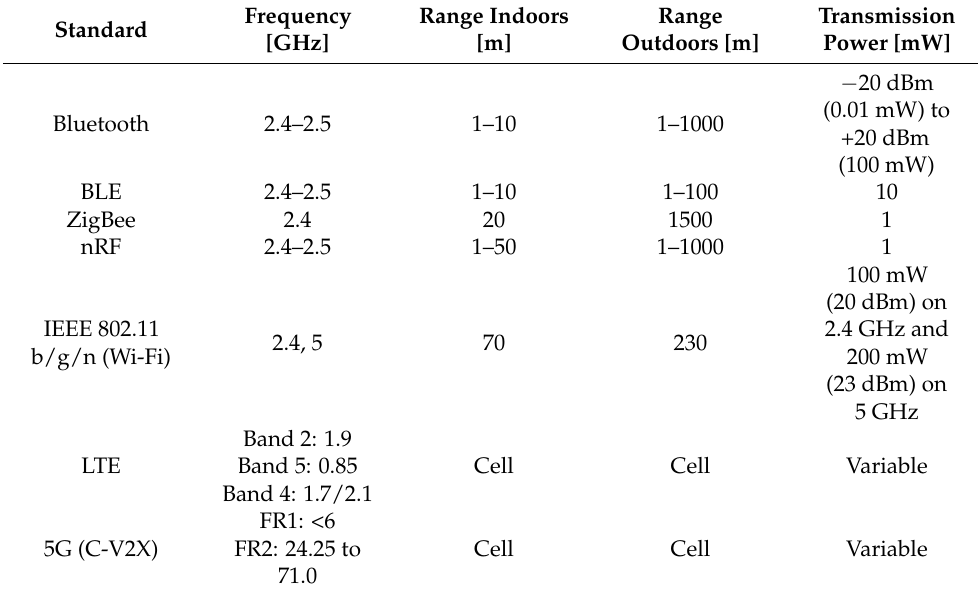
Table 1. Position of Bluetooth technology amongst similar communication technologies. Standard